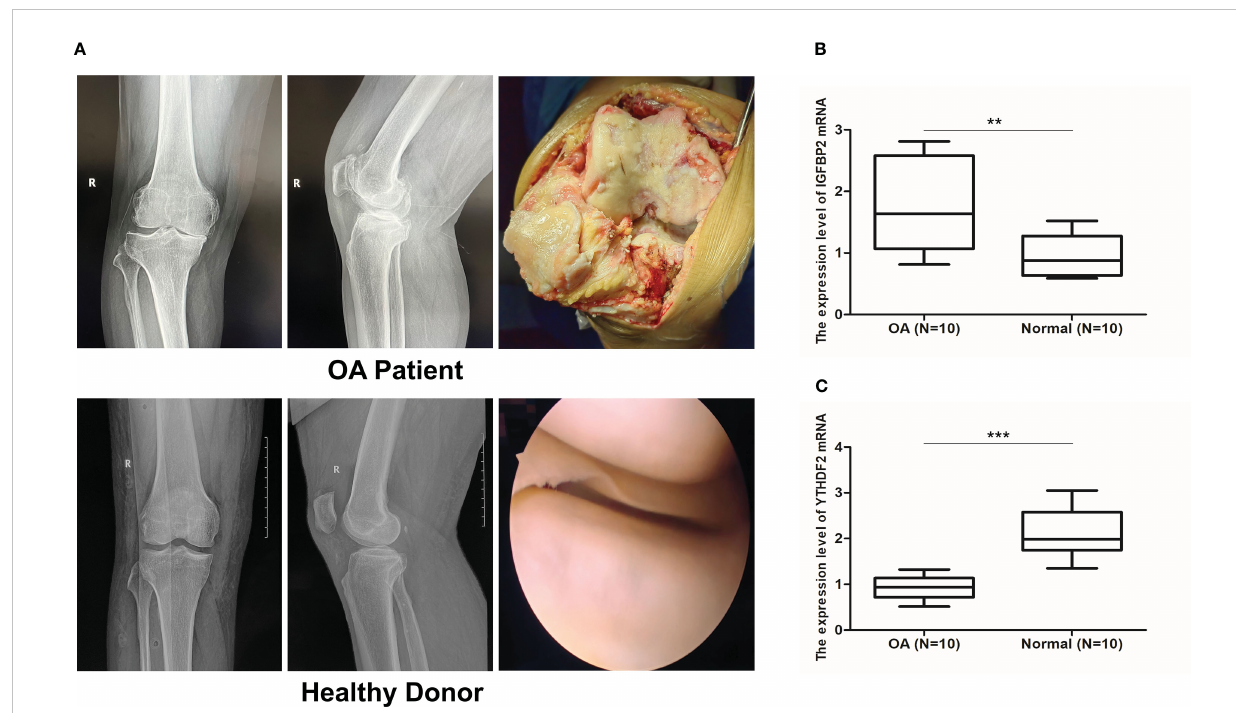
FIGURE 11 qRT-PCR validation of key m6A regulators. (A) X ray images and intraoperative macroscopic views (arthroplasty and arthroscopy image) of knee joint from OA patients and healthy donors. (B, C) Validation of IGFBP2 and YTHDF2 mRNA expression by qRT-PCR between OA (n = 10) and normal group (n = 10). **p < 0.01, and ***p <